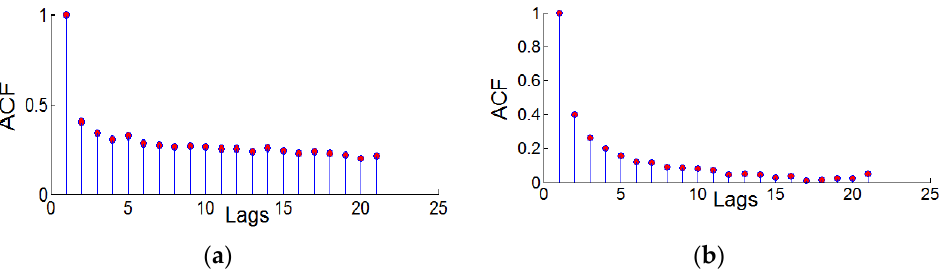
Figure 9. Autocorrelation plots of the squared series of elevation residuals of two CORS stations, ( a ) bjfs and ( b ) bogo.